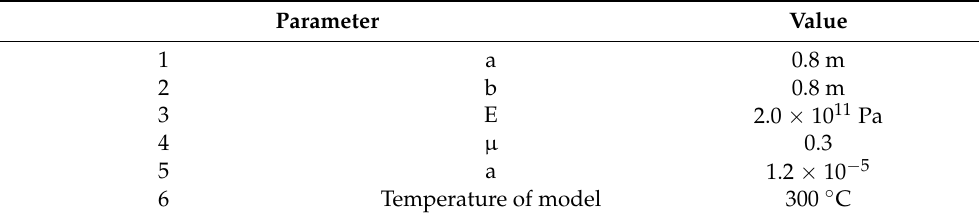
Table 7. Input parameters for thermoelasticity